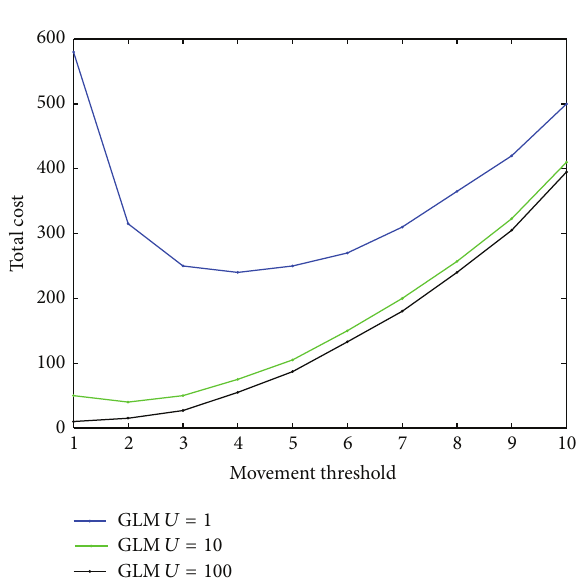
Figure 3: Paging cost for various CMR values.